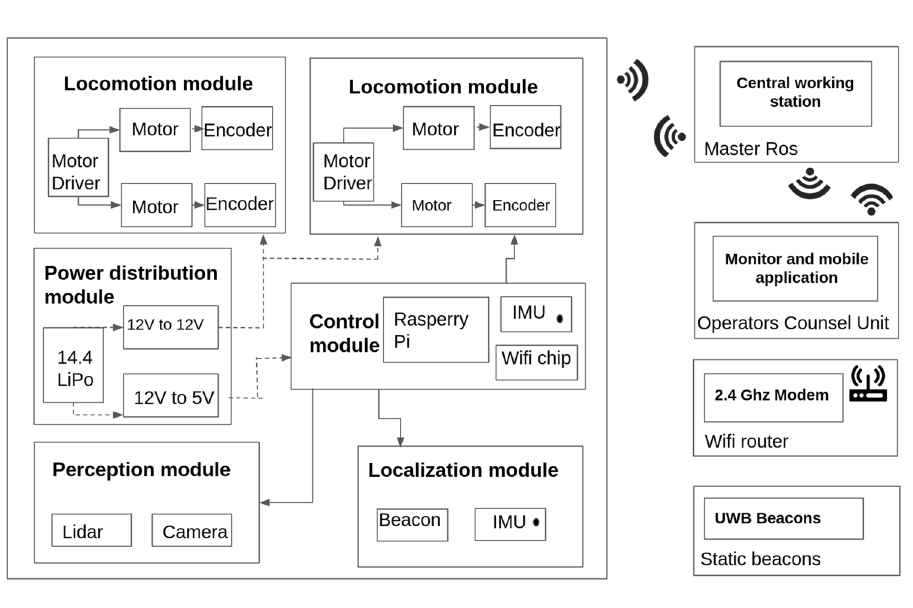
Figure 4. System